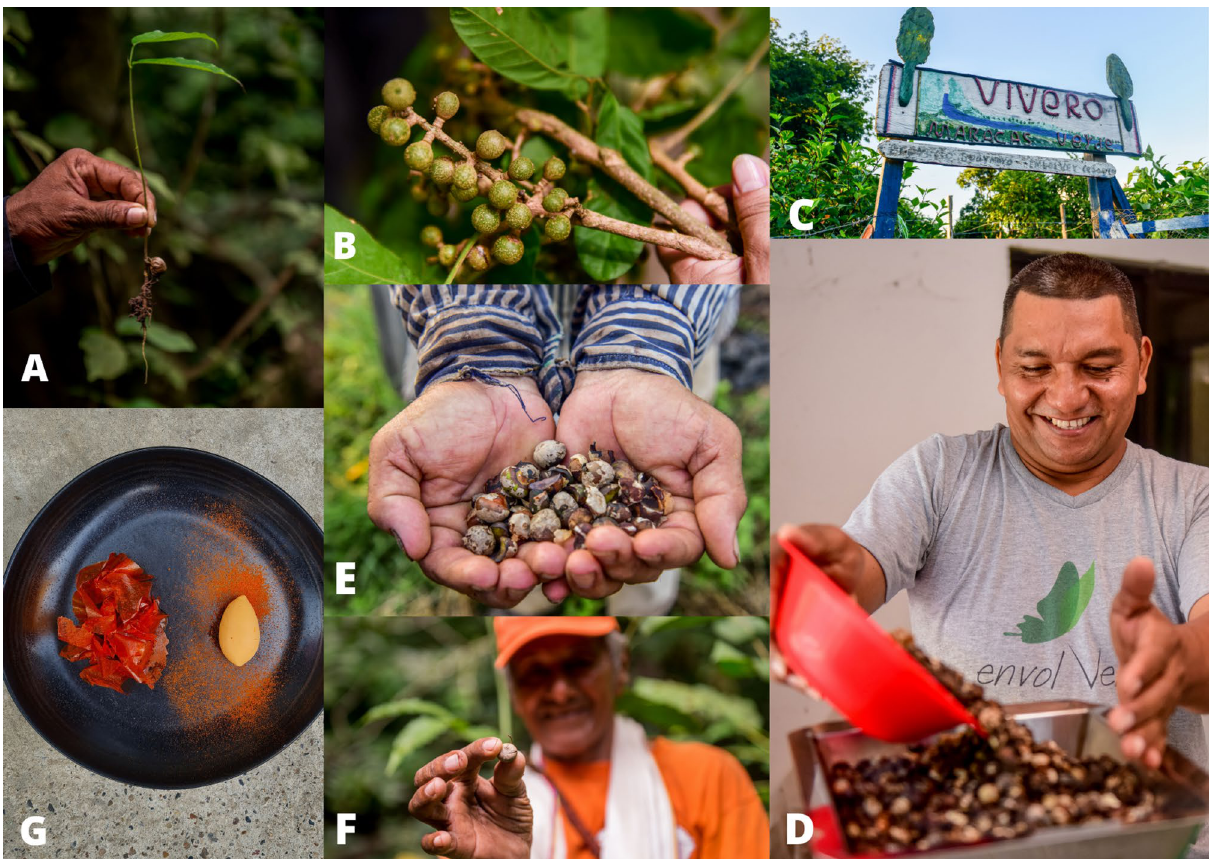
Figure 6. ( A ) Brosimum alicastrum germination from seed; ( B ) Brosimum alicastrum ’s fruit; ( C ) Community’s plant nursery; ( D ) Community member of Becerril processing Guáimaro seeds in the local facility; ( E ) Guáimaro seeds; ( F ) Guáimaro seed showed by a community member in Becerril; ( G ) Dessert prepared using Guáimaro ( B. alicastrum) by Chef Jaime Rodríguez Camacho at Celele restaurant in Cartagena. Credits: A-F) N. Plata; G) J. Rodriguez